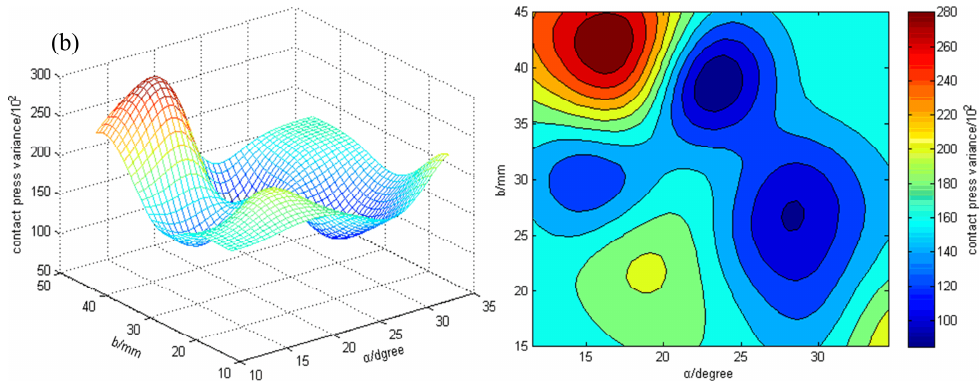
Figure 7. The sealing performance Kriging models of the VX gasket: ( a ) σ m Kriging model, and ( b ) S 2 Kriging.